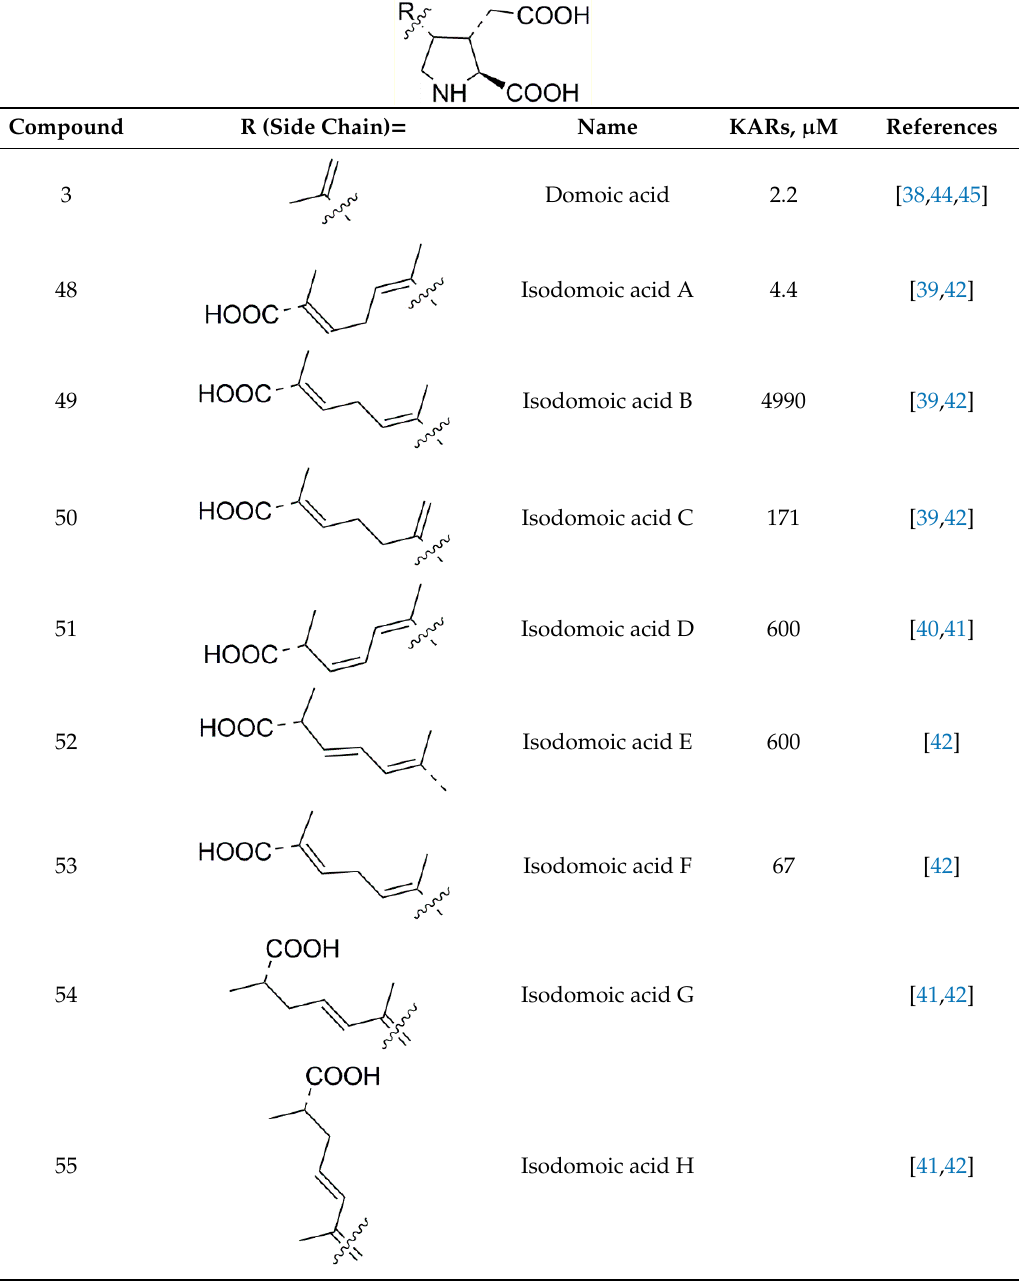
Table 1. Metabolites related to domoic acid.